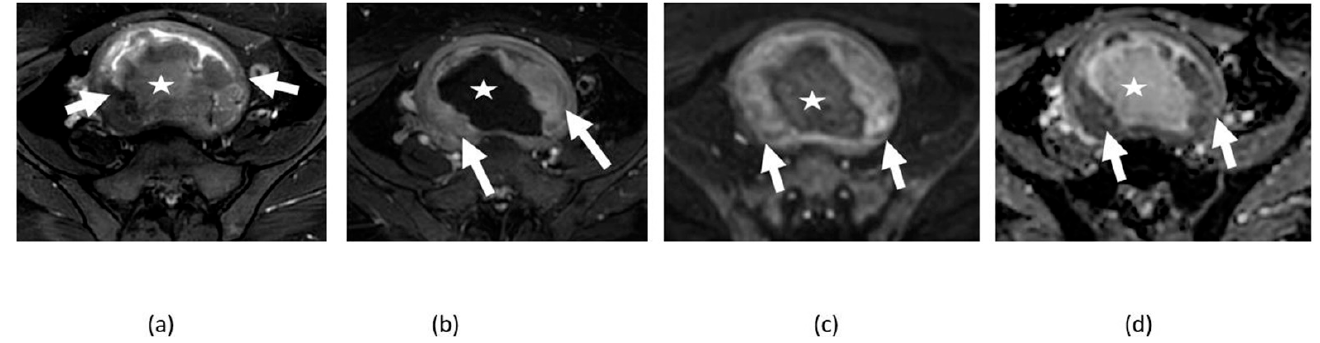
Figure 2. Axial T2-weighted ( a ), DWI ( b ), and ADC map ( c ) image of the pelvis shows T2 interme- diate signal submucosal fundal lesion showing restricted diffusion characterized by a high signal on DWI and low signal on ADC map, pathologically proven cellular leiomyoma (arrows).